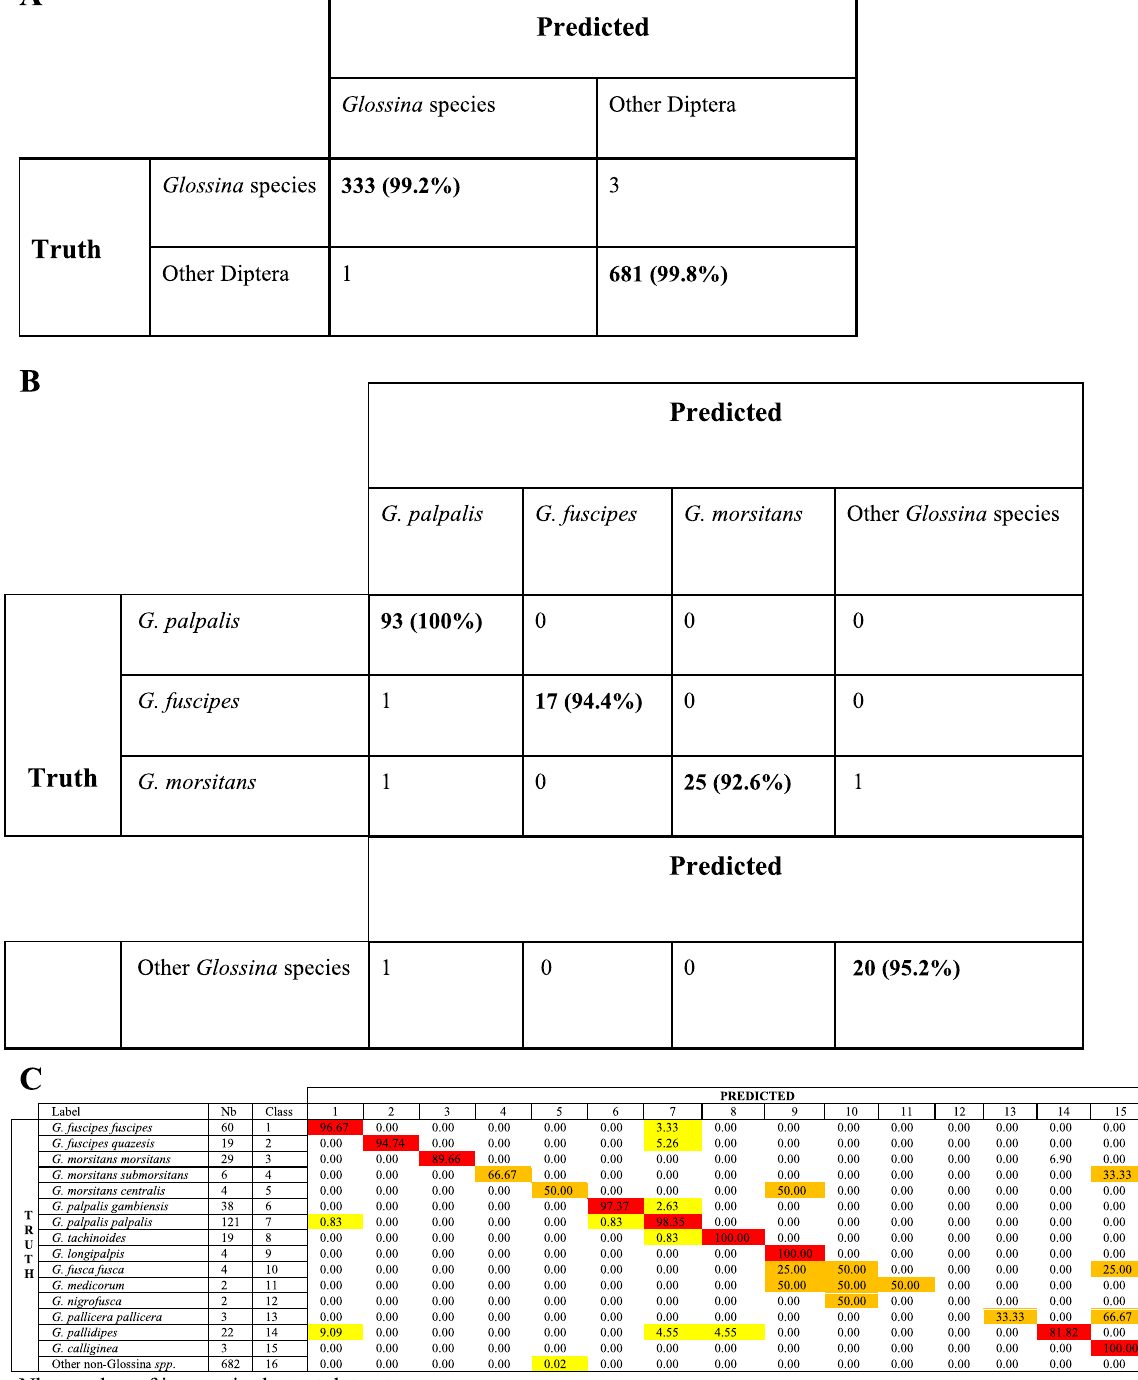
Table 3. Results and confusion matrix for Glossina versus other genera (A) of the classification of specimens belonging to the palpalis, morsitans, and fuscipes complexes (B) and at the species and subspecies level (C). Nb: number of images in the test